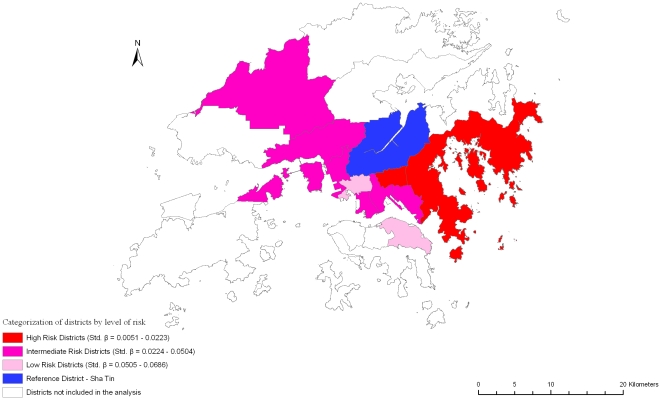
Risk variation in self-rated mental health (SF-12 mental) across districts.